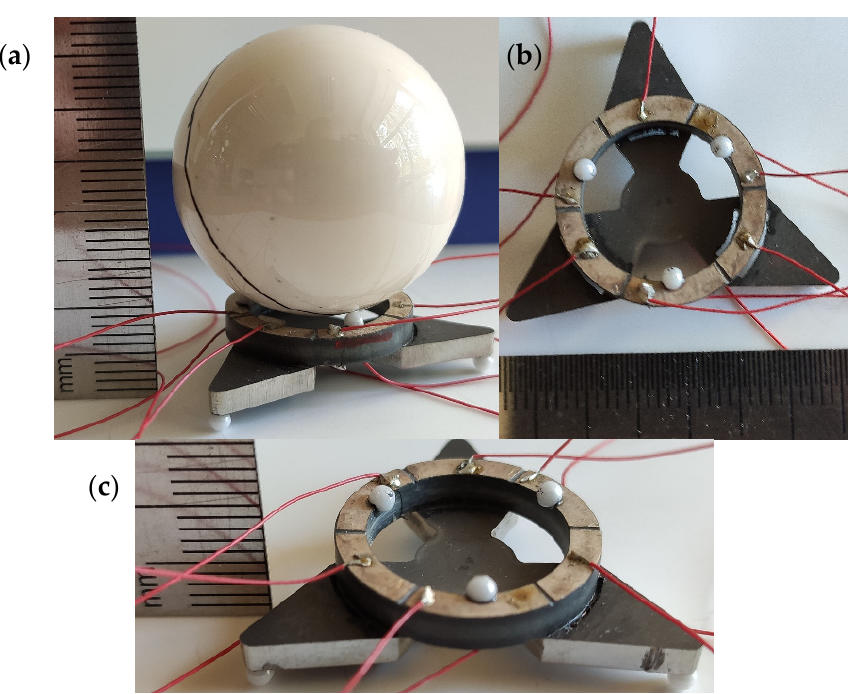
Figure 13. Prototype of the robot: ( a )—side view with payload; ( b )—top view without payload; ( c )—side view without payload.